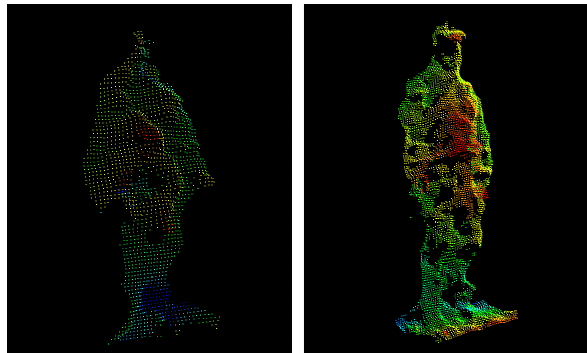
Figure 4: Exemplary point clouds of the same person in different imaging